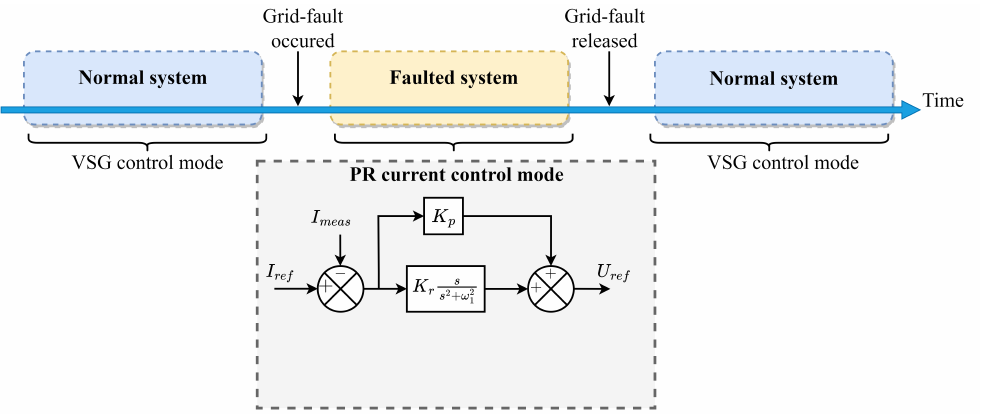
Figure 24. Control schematic diagram and PR regulator control block diagram [122].